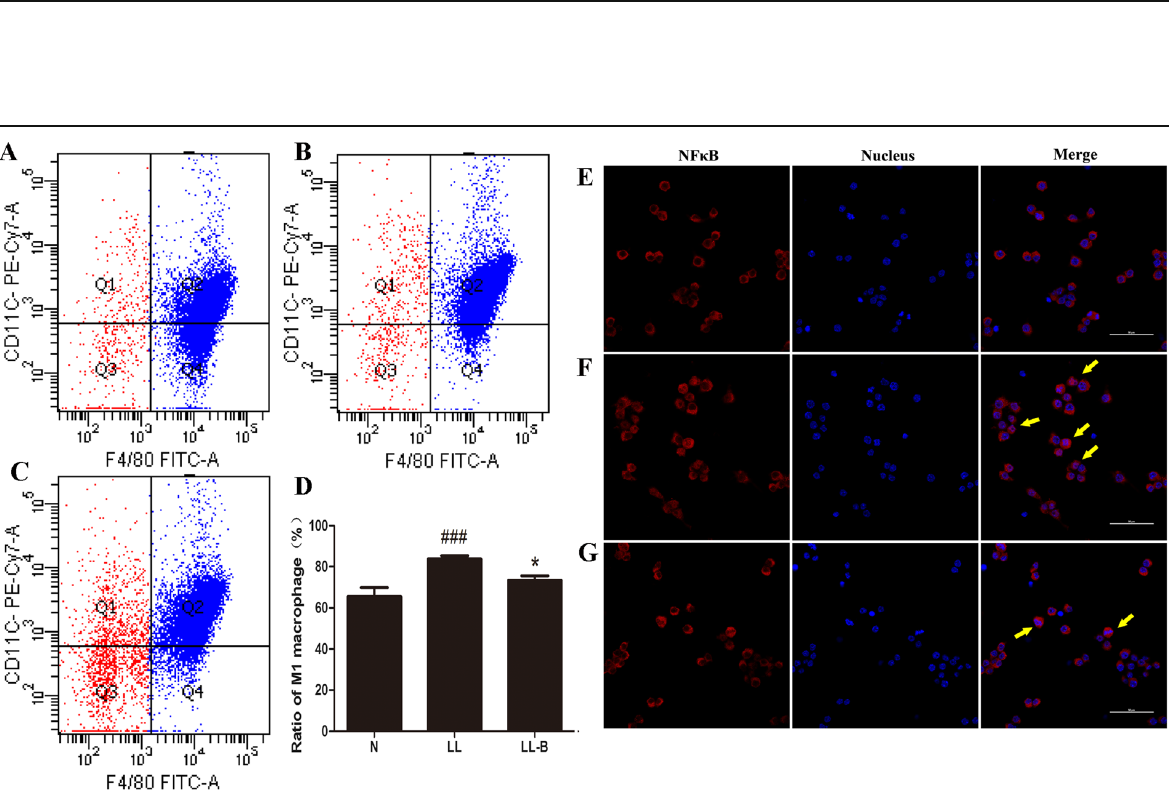
Fig. 7 Effects of BBR on the M1 ratio ( a - d ) and nuclear translocation of NF κ B ( e - g ) after LPS intervention for 3 h in primary peritoneal macrophages. a CD11c + ratio in normal control group. b CD11c + ratio in Low LPS group. c CD11c + ratio in low LPS + BBR group. d Compared with N group, ### P < 0.001; compared with LL group, * P < 0.05. e Nucear transloacation of NF κ B p65 in normal control group. f Nucear transloacation of NF κ B p65 in LL group. g Nucear transloacation of NF κ B p65 in LPS + BBR group. Red, NF κ B p65; blue, nucleus; purplish red, NF κ B p65 in nucleus. Yellow arrows, marked nucear transloacation of p65 NF κ